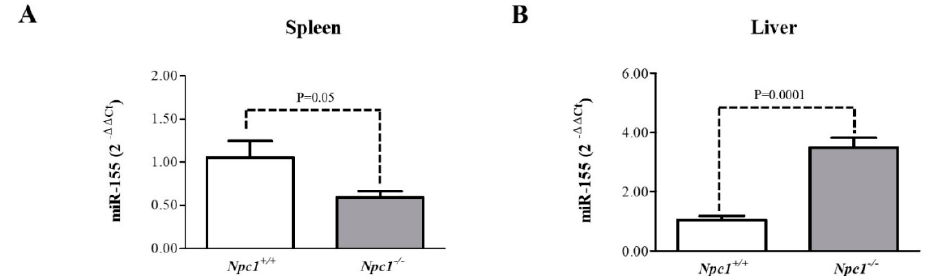
Figure 6. miR-155 analysis of spleen and liver tissue from 9-week Npc1 +/+ and Npc1 − / − mice. miR-155